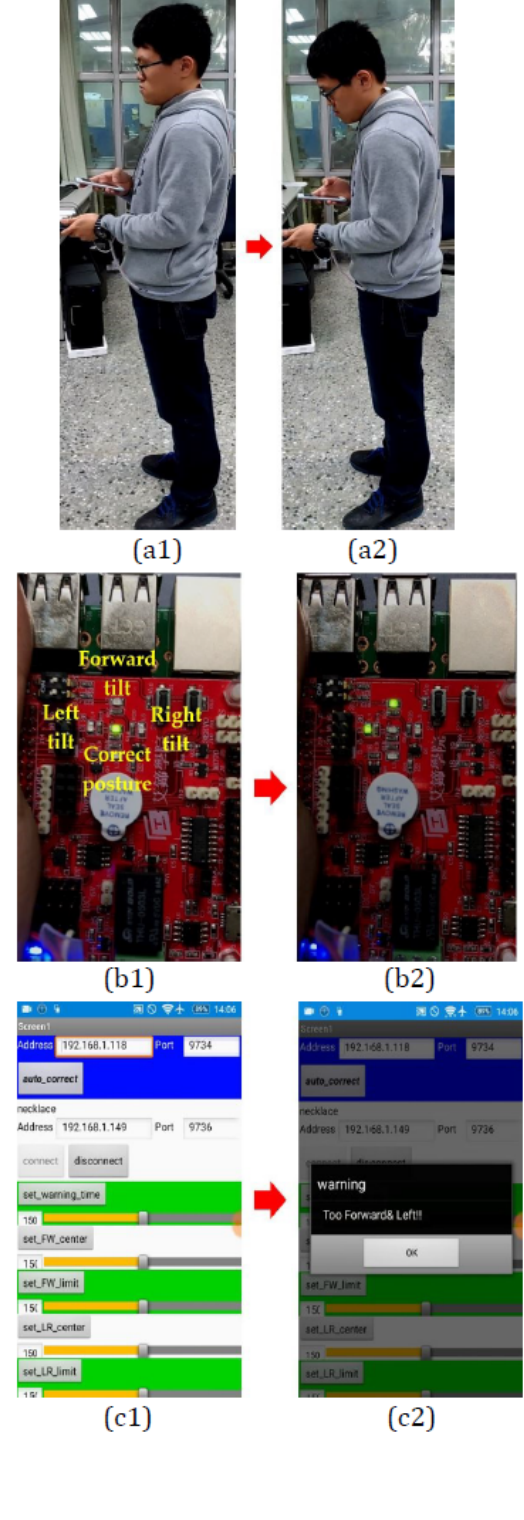
Figure 21. Posture with forward-left